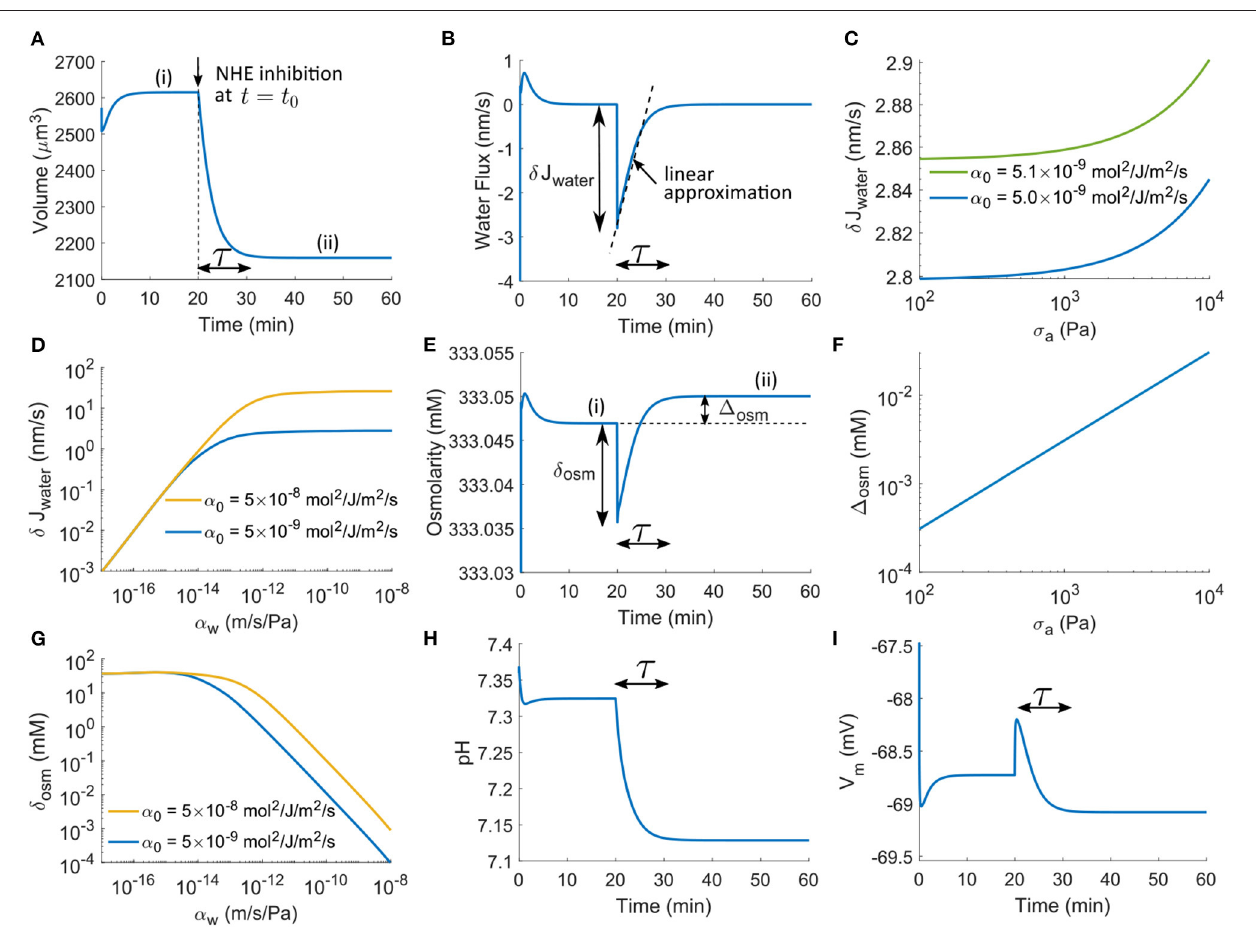
FIGURE 2 | Model prediction on the cell transient response upon NHE inhibition applied at t 0 = 20 min by reducing α NHE by three orders of magnitude. (A) Transient response of cell volume as a function of time. τ is the time scale of the transient regime. (B) Transient response of cell water flux. (C) The maximum magnitude of the transient water flux upon NHE inhibition as a function of cortical stress, σ , for different α 0 . (D) The maximum magnitude of the transient water flux upon NHE inhibition as a function of the water permeability coefficient, α w , for different α 0 . (E) Transient response of intracellular osmolarity. The extracellular osmolarity is 333 mM. (F) The magnitude of the steady-state osmolarity difference before and after NHE inhibition as a function of cortical stress σ a . (G) The magnitude of the osmolarity difference before and after NHE inhibition as a function of α w for different α 0 . (H) Transient response of the intracellular pH. (I) Transient response of the cell membrane